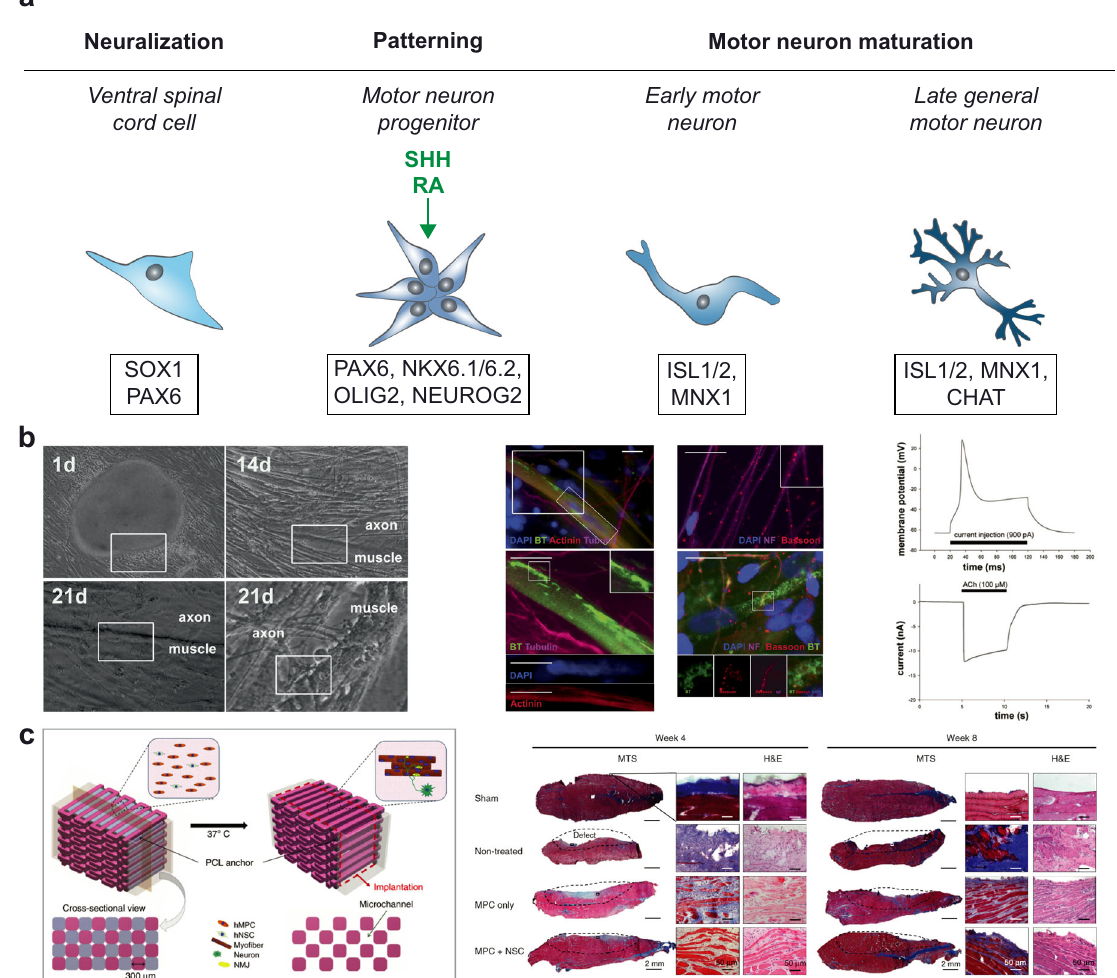
Fig. 9 Motor neuron development and co-culture with skeletal muscle cells: in fl uence on myogenesis. a Representation of the formation of motor neurons. Marker genes are shown in the bottom boxes, while the main signaling molecules are indicated in green if acting as pro- differentiative factors. b Left: representative phase-contrast images of a human iPSC-derived moto-neurosphere at different time points after plating. Small neurites were outgrowing from the moto-neurosphere. In the inserts are shown contacts between neurites and myotubes. Middle left: maturation of acetylcholine receptor clusters and neuromuscular junction formation. Co-culture between human iPSC-derived motor neurons with CD34-enrichment derived myotubes. α -Bungarotoxin ( α -BT) labeling after 21 days indicates the formation of a mature neuromuscular junction. Middle right: Bassoon labeling after 21 days indicates presynaptic terminals along the axons (top fi gure). At the end plate region, a close apposition between presynaptic and postsynaptic markers could be detected, as shown by Bassoon and α -BT stainings (bottom fi gure). Scale bar: 20 μ m. Right: electrophysiological properties of myotubes in culture after differentiation and representative traces of current-clamp measurements and the generation of an action potential following acetylcholine treatment. MP resting membrane potential, AP action potential. Images reproduced with permission from 202 . c Left: scheme of a bioprinted construct with the cell-laden bioink, the acellular sacri fi cing bioink, and the supporting polycaprolactone pillar. Right: histological examination of skeletal muscle regeneration through the 3D bioprinted constructs at 4 and 8 weeks after implantation. Dashed lines: defected area; MTS: Masson ’ s trichome staining; H&E: hematoxylin and eosin. Images reproduced with permission from 134 ectoderm, the dorsoventral patterning of the neural tube begins thanks to the action of WNT; TGF β family proteins, and retinoic acid from surrounding regions (Fig. 1b). The ventrodorsal gradient of SHH is crucial: the cells exposed to the highest levels of SHH are the motor neuron progenitors, expressing NK6 homeobox 1 (NKX6.1), the oligodendrocyte transcription factor 2 (OLIG2), and PAX6. The differentiation program starts at this point, stimulated by retinoic acid signaling and OLIG2. OLIG2 together with one of its targets, neurogenin 2 (NEUROG2), contribute to promoting motor neuron fate, by inducing the expression of motor neuron and pancreas homeobox 1 (MNX1 or HB9) (Fig. 9a). MNX1, which is a speci fi c marker for postmitotic spinal motor